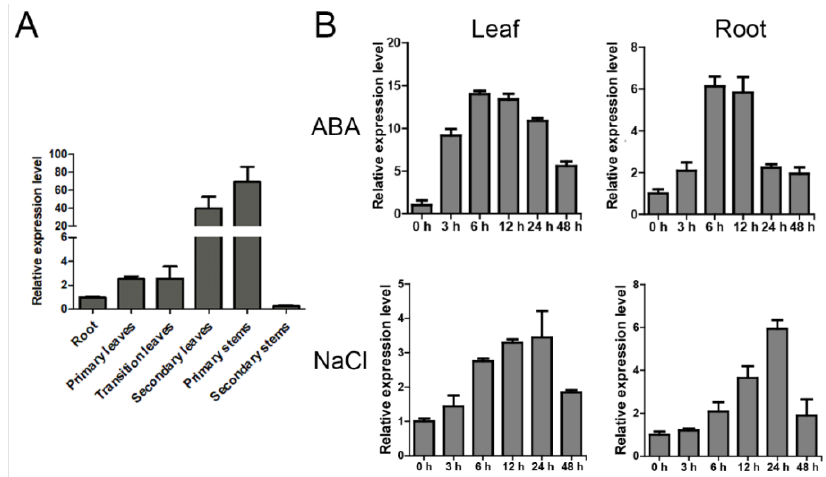
Figure 3. Expression patterns of the PagERF072 gene in leaves and roots under salt stress and ABA treatments. ( A ) Expression levels of the PagERF072 gene in different tissues. ( B ) Expression patterns of PagERF072 in response to NaCl and ABA. Data were processed using the 2 −ΔΔ Ct method. Error bars represent standard deviation.